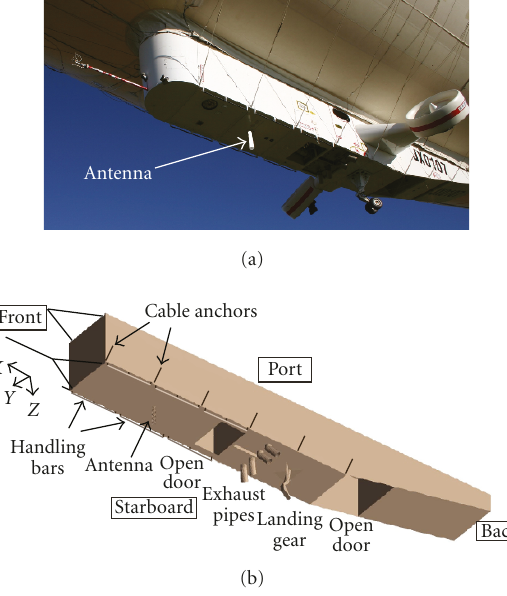
Figure 7: Photograph of the airship gondola from below and FEKO